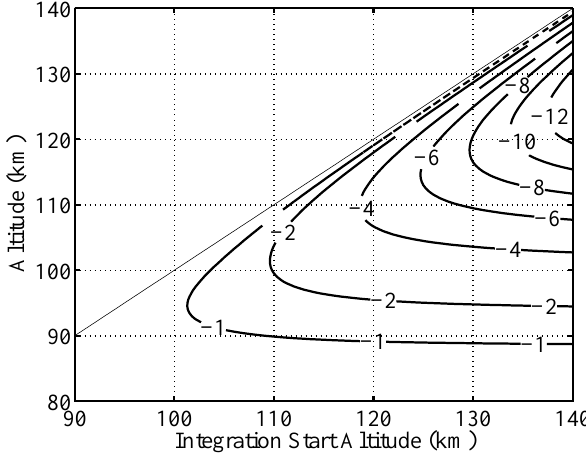
Fig. 6. Mid latitude – measurements made during quiet solar activ- ity and processed assuming moderate solar activity, except that the temperatures used to seed the retrieval are for quite solar activity.